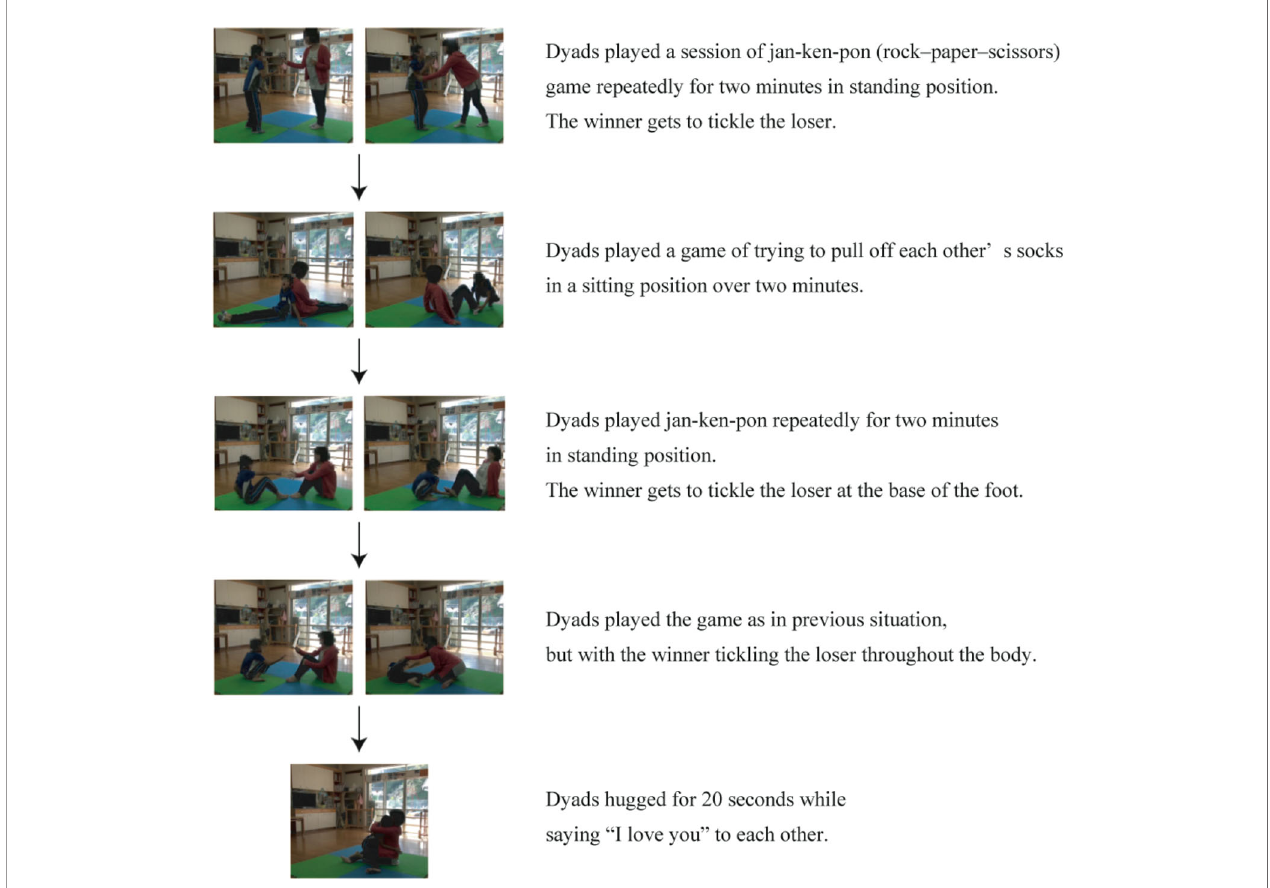
FIGURE 2 | Intervention: Playful Mother – Child Interaction. Intervention protocol with representative images for each procedure was